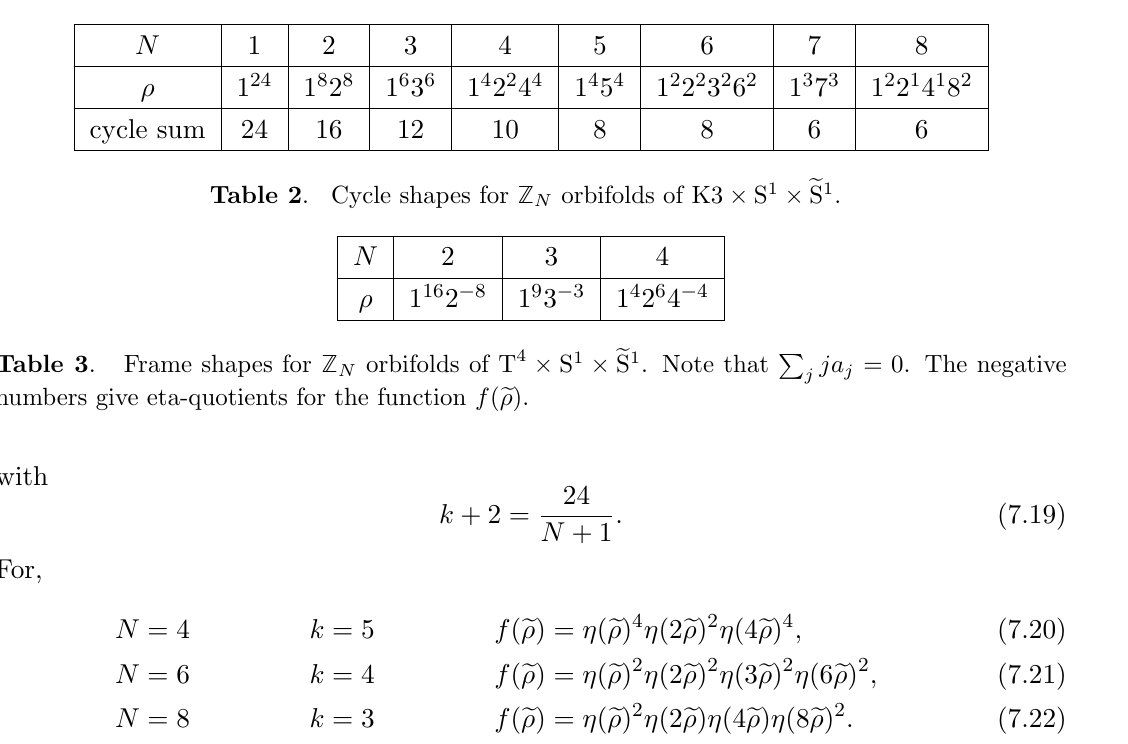
(cid:11) nicely ties up with the shifted partition function (7.7) as e